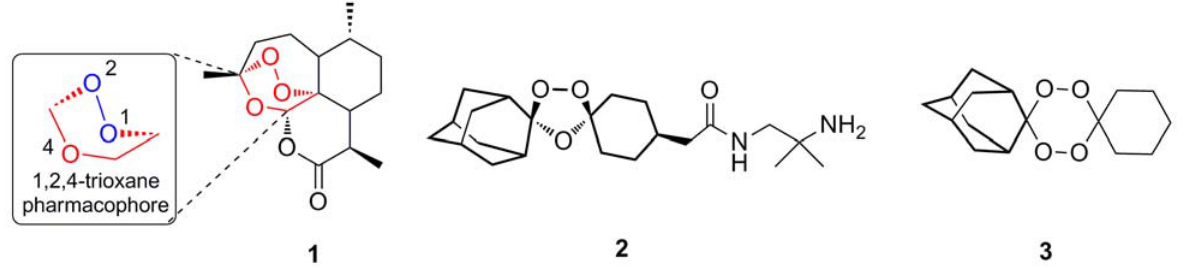
Figure 1. Antimalarial